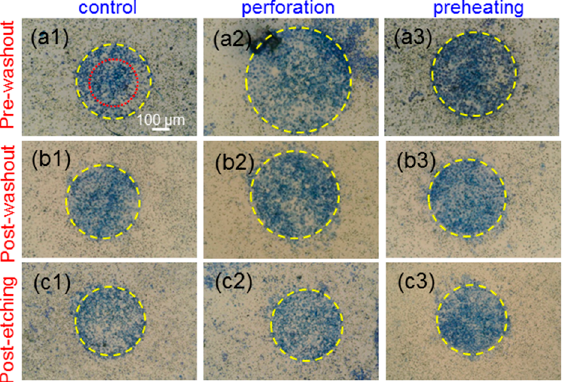
using the focused 1064-nm fs laser. Molecules 2018 , 23 , x illuminated